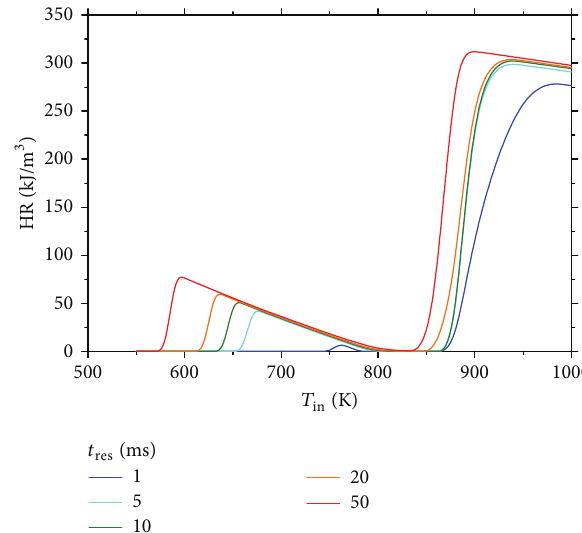
Figure 2: Predictions of heat release per unit volume as a function of inlet temperature for 5 characteristic values of fuel concentration = 30 ms). ( 𝑡 res